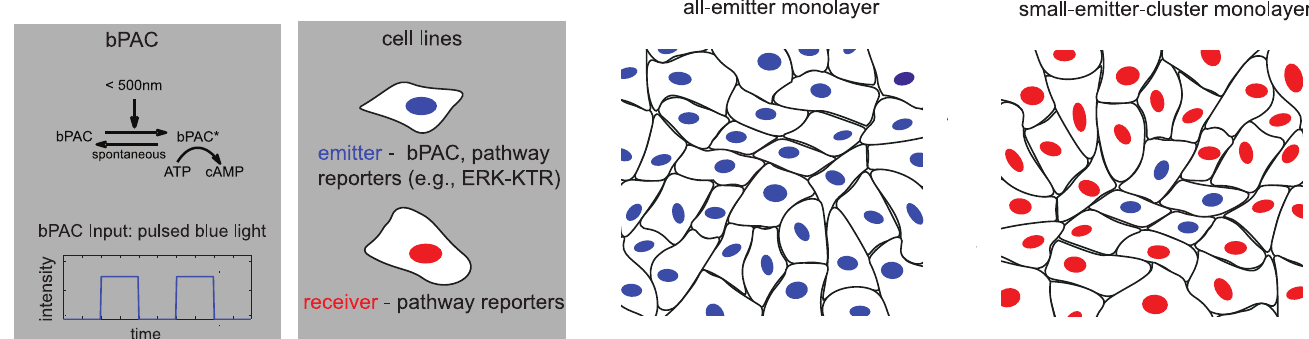
Fig 1. Application of optogenetics to study the effects of localized cAMP perturbations in epithelial monolayers. Optogenetic approach to study the effects of localized cAMP perturbations in monolayers: First panel: Top: bPAC, a blue light responsive adenylyl cyclase from bacteria. Bottom: The bPAC input is a sequence of spatially-uniform, constant amplitude (between 0 and 1) pulses of blue light. Second panel: Cell lines: The emitter has bPAC and pathway reporters while the receiver has only pathway reporters. Third panel: Monolayer of just emitters (spatially uniform cAMP perturbation). Fourth panel: Monolayer with a small emitter cluster surrounded by receivers (localized cAMP perturbation). We define a small emitter cluster as a concentrated group of 15 or less emitters.